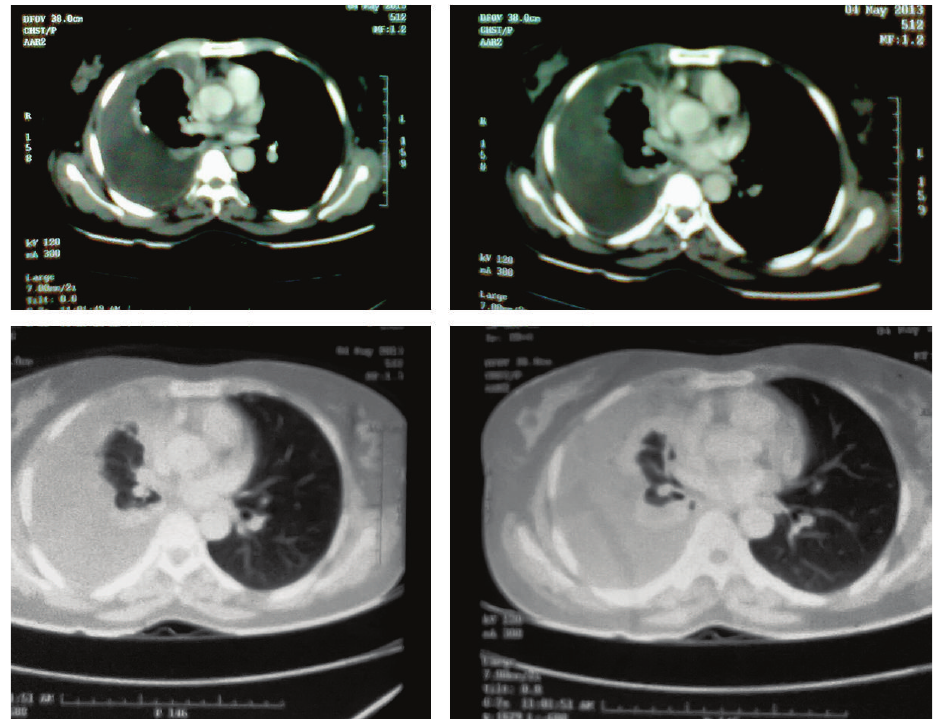
Figure 2: CECT of thorax showing right-sided pleural effusion.